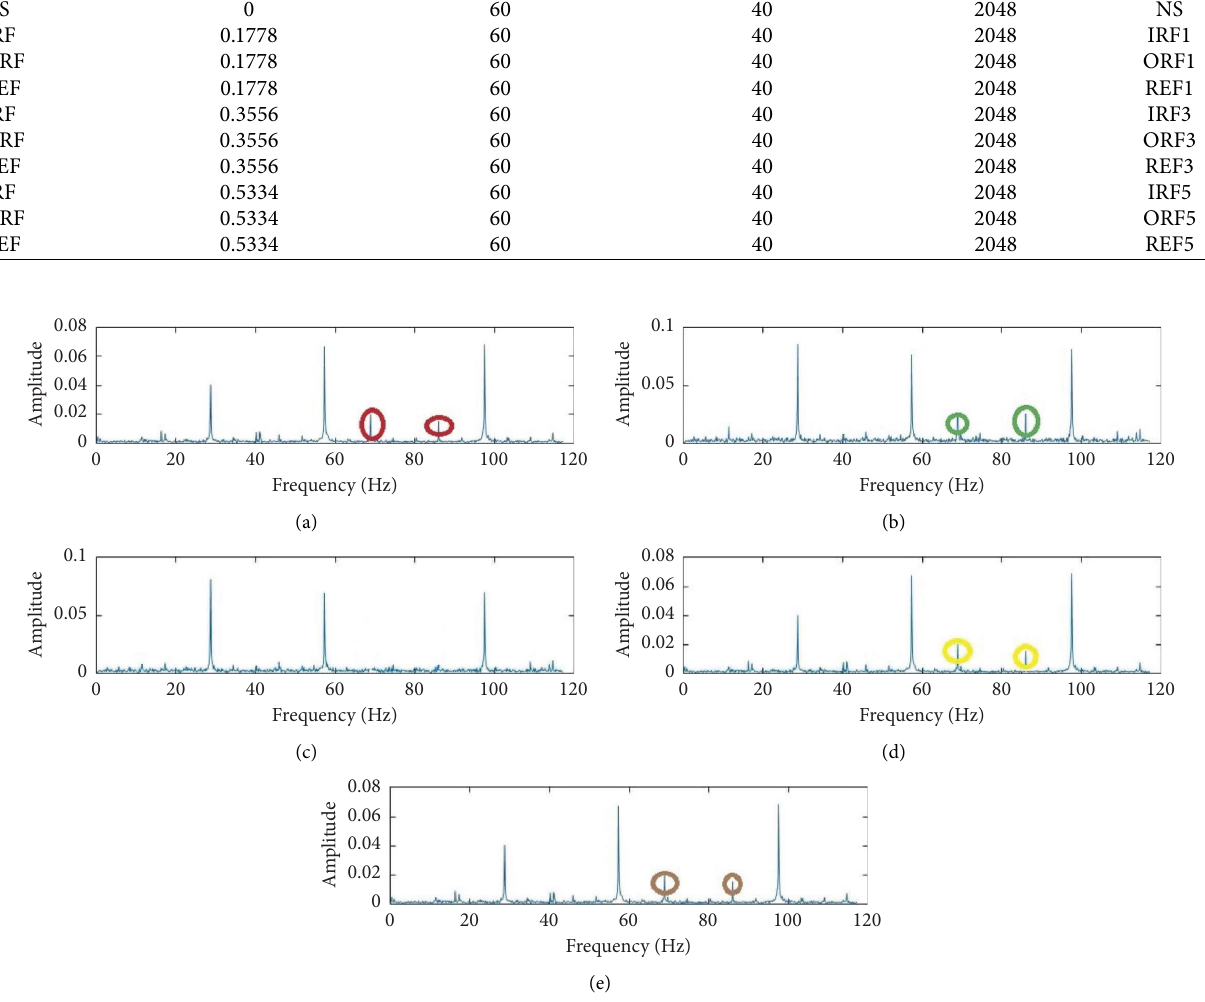
Figure 8: Envelope spectrums of original signal and denoise signal using diferent methods. (a) Envelope spectrum of original signal. (b) Envelope spectrum of denoise signal by single-scale CMF. (c) Envelope spectrum of denoise signal by multi-scale CMF. (d) Envelope spectrum of denoise signal by EMD. (e) Envelope spectrum of denoise signal by are extracted. One training sample of IRF1 is selected to show the selection process of optimal r . Te computation